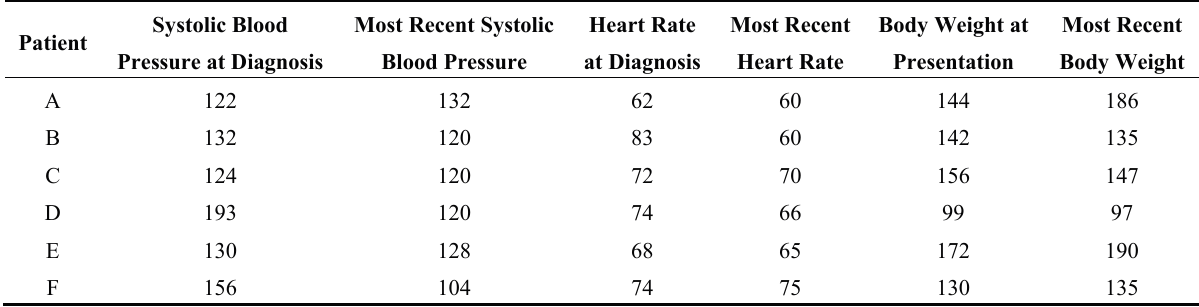
Table 4. Changes in blood pressure, heart rate, and body weight with medical